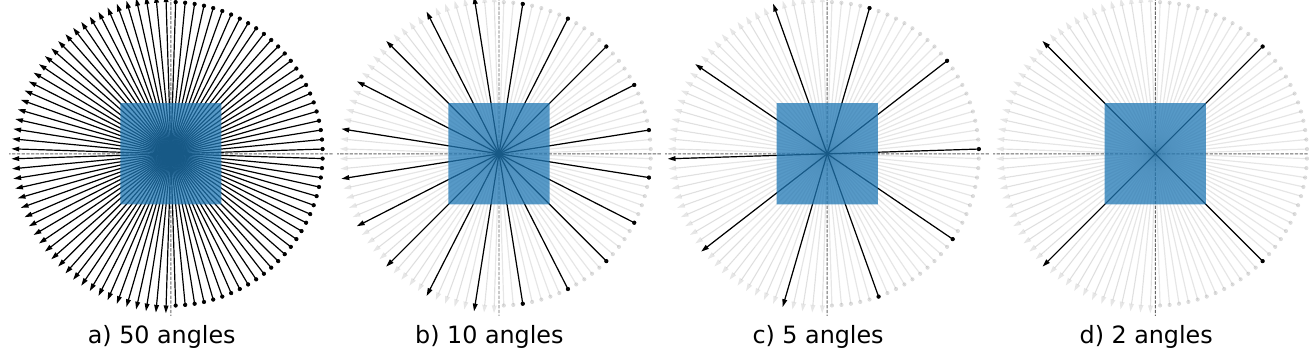
Figure 2. The angular sampling ranges employed for sparse image reconstructions for ( a ) 50 (full), ( b ) 10 (subset of 50 angles), ( c ) 5 (subset of 50 angles) and ( d ) 2 angles (subset of 10 angles). The black arrows show the position of the X-ray source (dot) and the position of the detector (arrowhead). For the sparse-angle scenario, the unused angles are shown in light